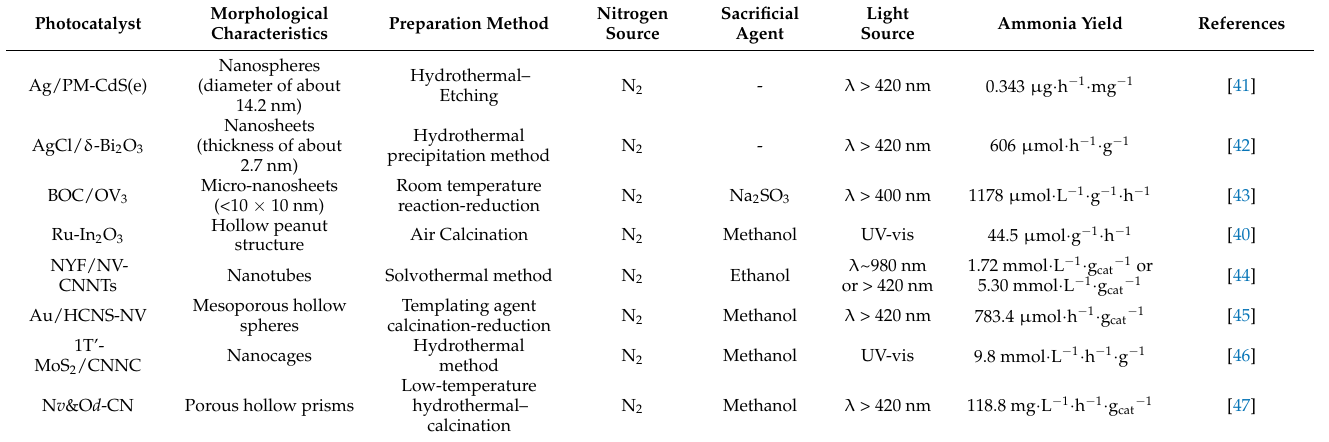
Table 2. Comparison of recent photocatalysts with specific morphologies and nitrogen fixation